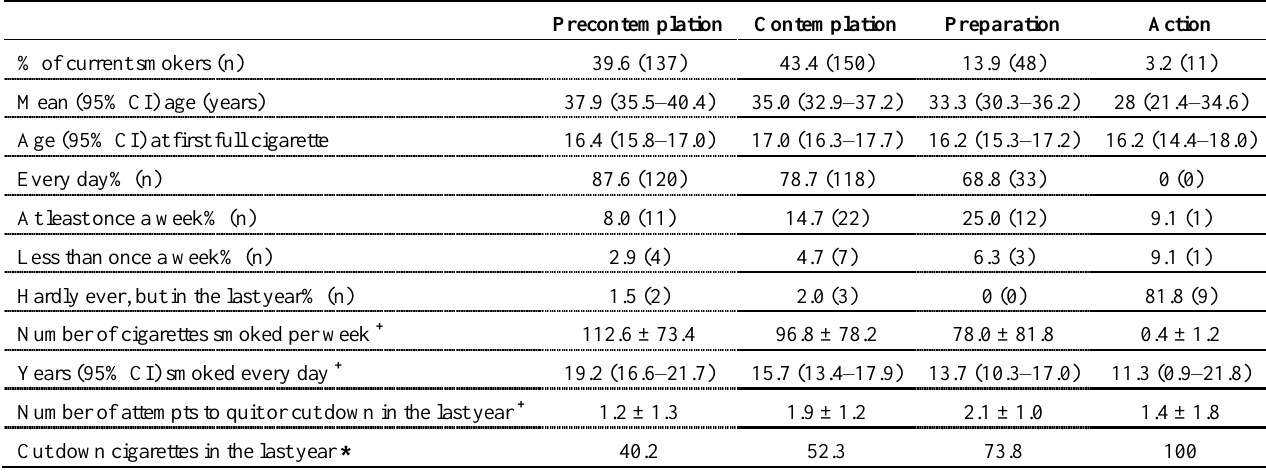
Table 2. Smoking behaviour, intake and quit attempts of current smokers categorised by stage of